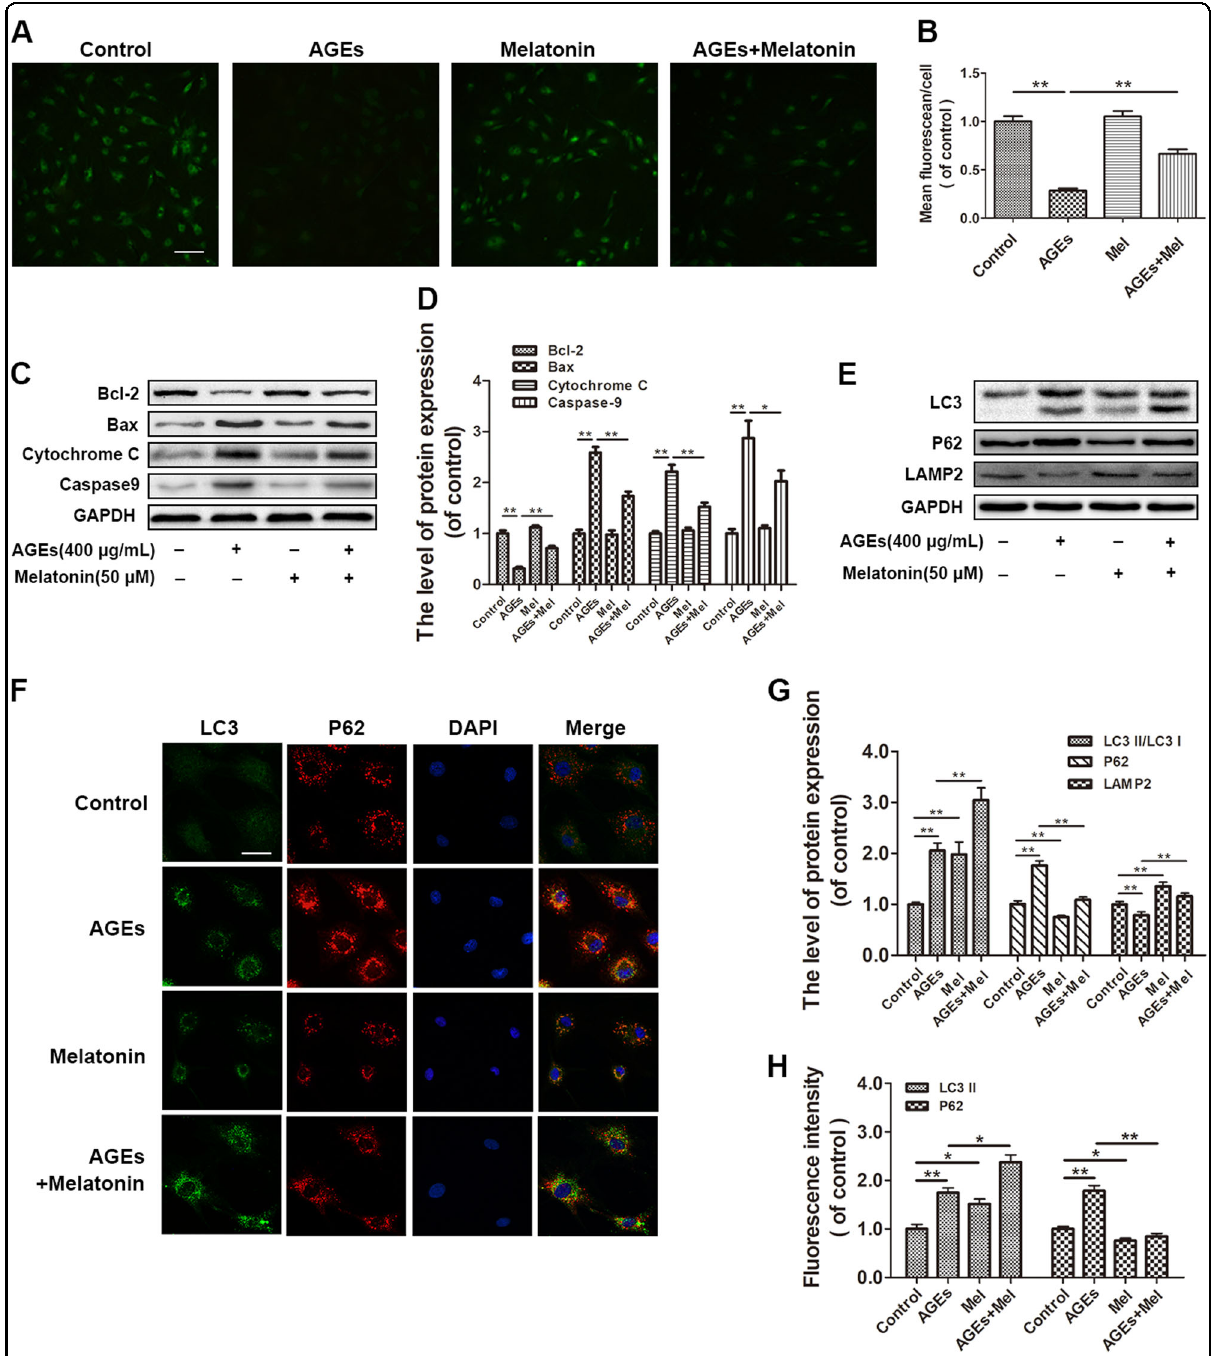
Fig. 2 Melatonin reduces mitochondrial functional damage and promotes autophagy fl ux in AGE-treated EPCs. EPCs were pre-treated with 50 μ M melatonin for 2 h and then 400 μ g/mL AGEs were added for an additional 24 h. a , b Mitochondrial permeability transition pore (mPTP) opening was detected by co-loading with calcein-AM and cobalt. Scale bar, 50 μ m. c , d Protein expression levels of Bcl-2, Bax, cytochrome c, and caspase-9 in EPCs of each group treated as described above. e , g Protein expression levels of LC3, p62, and LAMP2 in EPCs treated as described above. f , h Double immuno fl uorescence of LC3 protein (green) and p62 protein (red) in EPCs. Scale bar, 25 μ m. Data are presented as the mean ± SEM. Signi fi cant differences between the treatment and control groups are indicated as ** P < 0.01 or * P < 0.05. n =